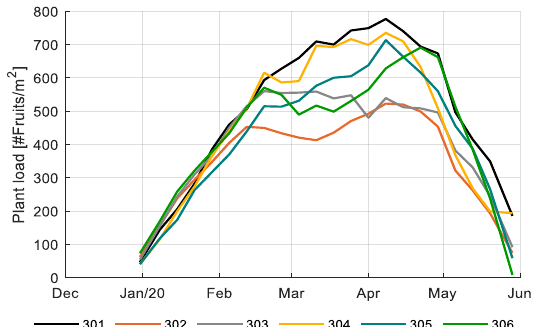
Figure 14. Stem density (# stems/m 2 ) and topping dates (-o-) in different greenhouse compartments (301–306).